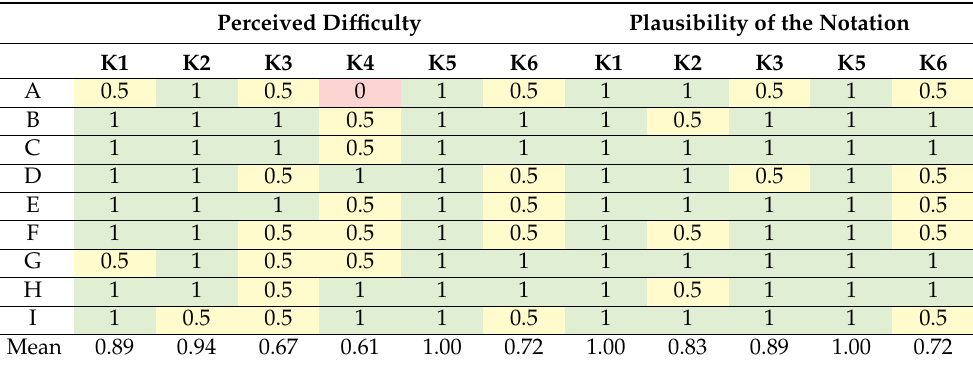
Table 12. Perceived difficulty and plausibility of the notation for each key idea. Kx stands for key idea x, cf. Table 1. The responses are color coded such that 1 is green, 0.5 is yellow and 0 is